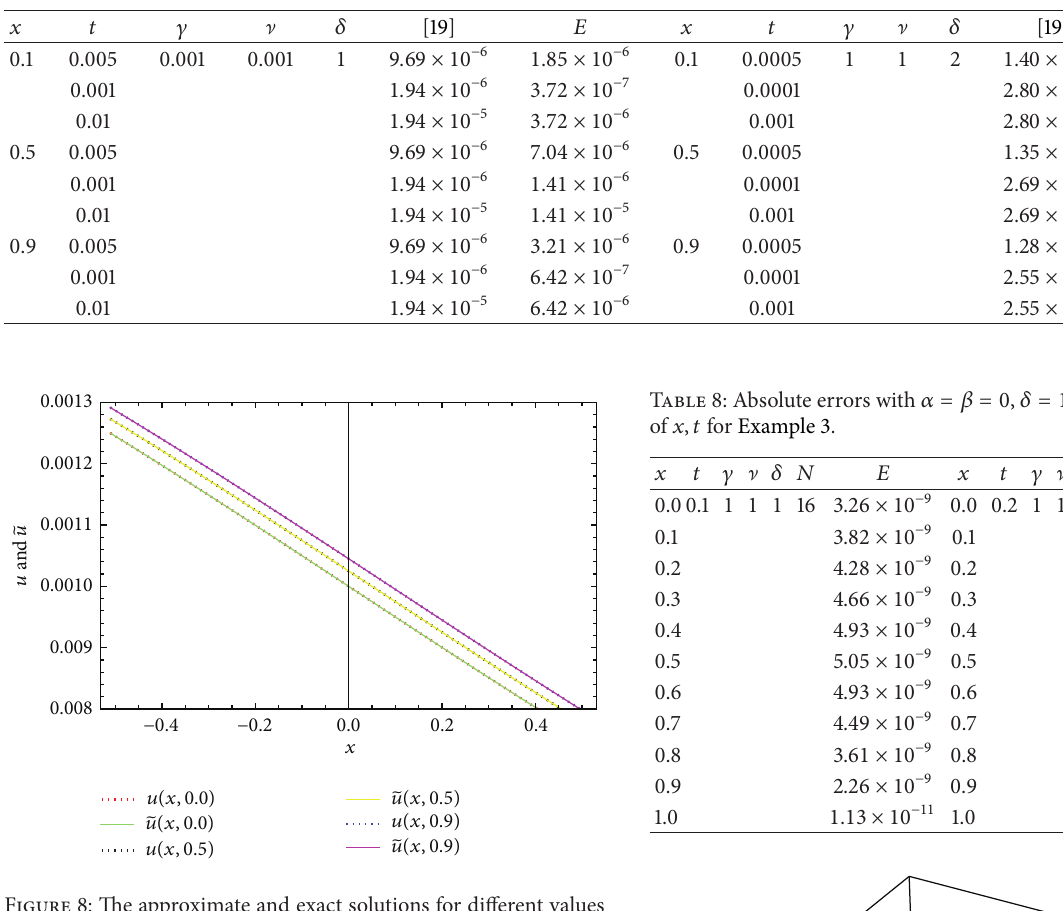
Table 7: Comparison of absolute errors of Example 3 with results from [19], where 𝑁 = 4 , 𝛼 = 𝛽 = 0 , and various choices of 𝑥, 𝑡 .